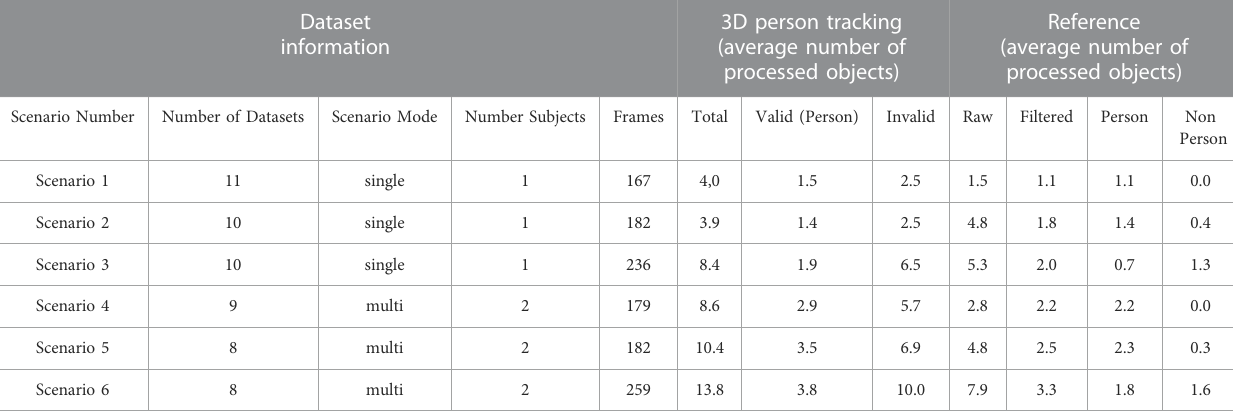
table ’ s end, each column ’ s mean and median is calculated for comparison against the other scenarios.